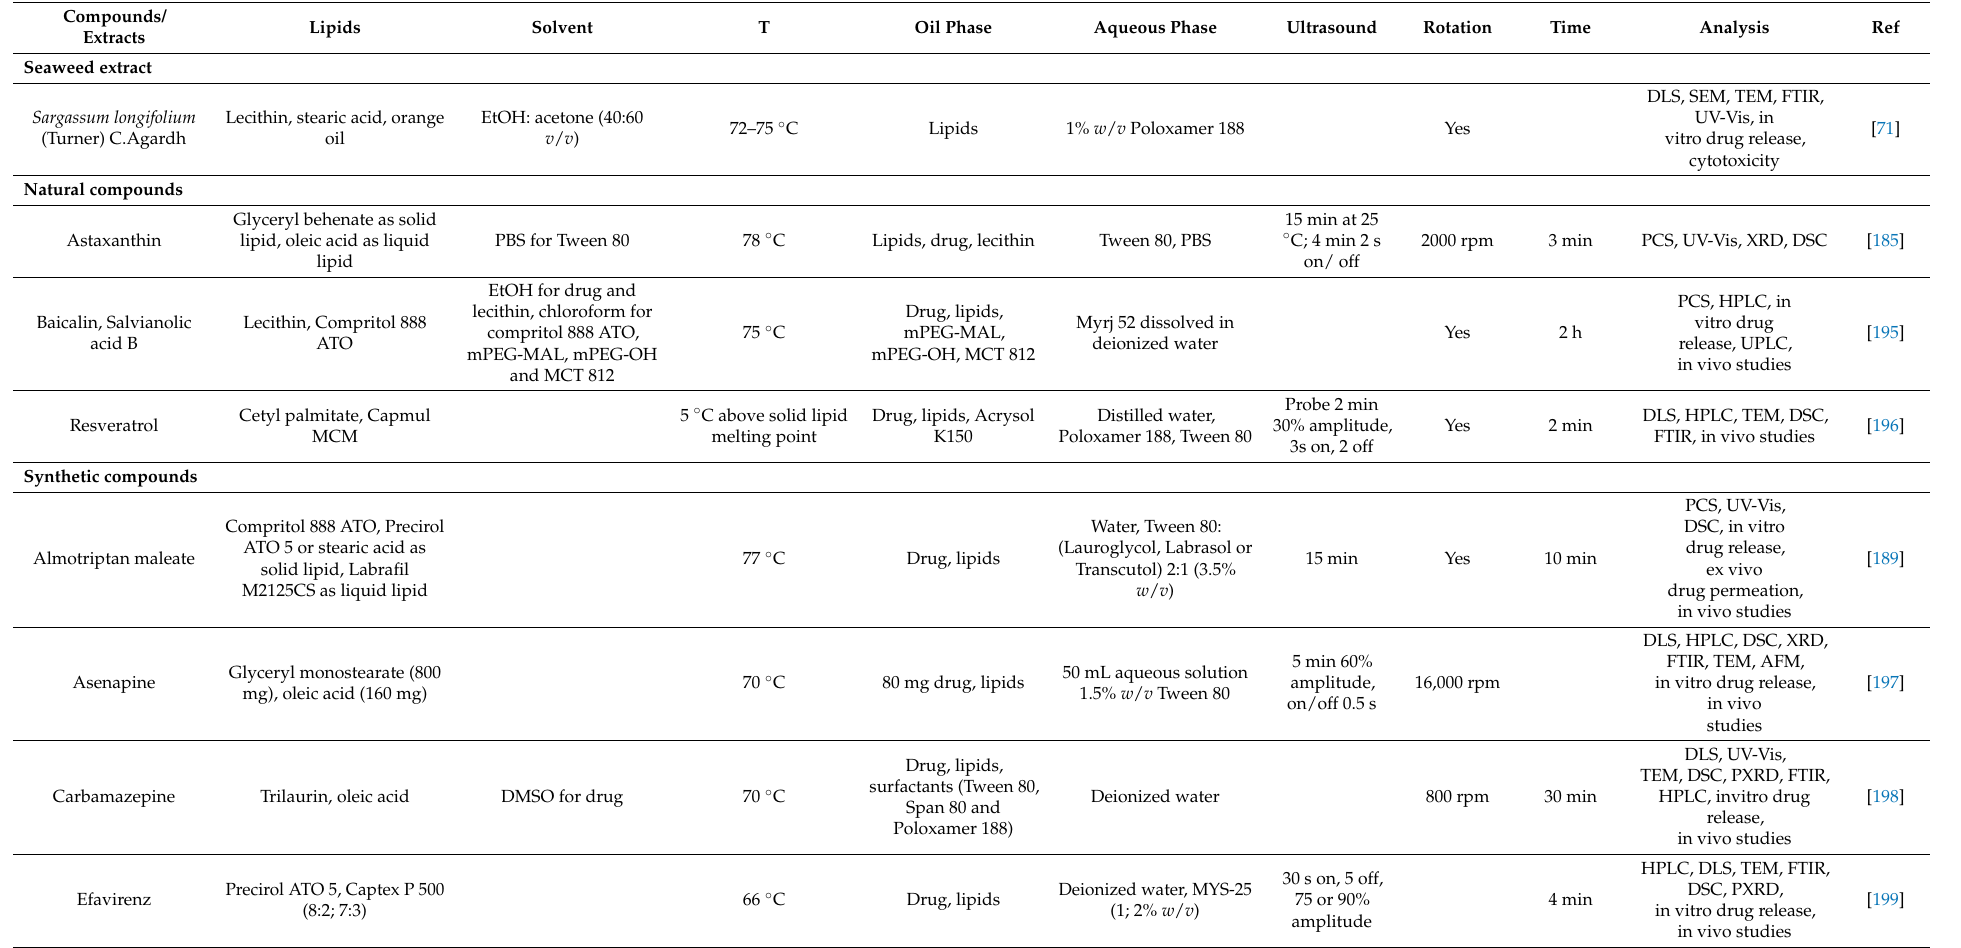
Table 5. NLCs produced to encapsulate neuroprotective compounds and